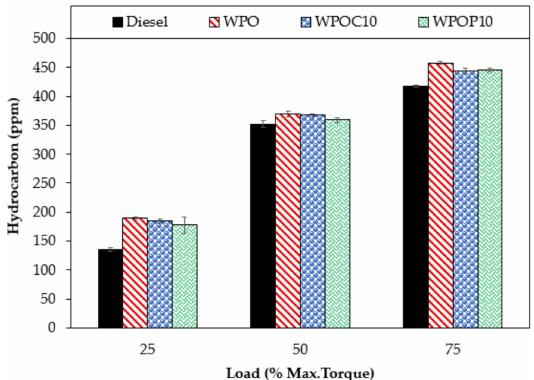
Figure 10. Hydrocarbon emissions.